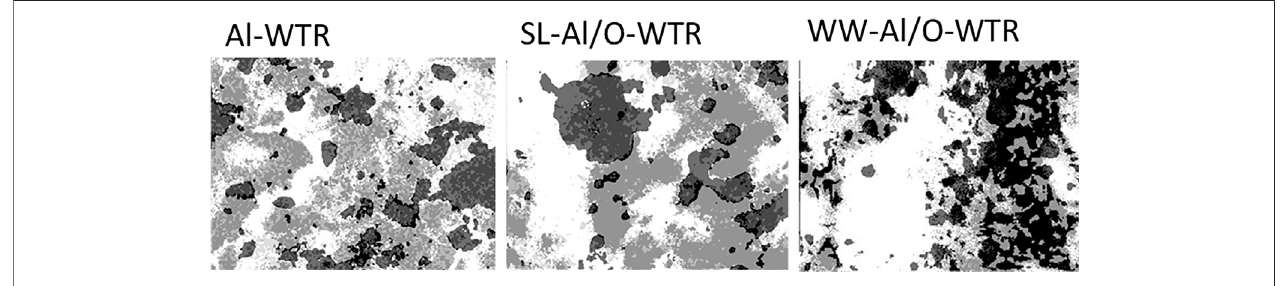
FIGURE 5 | The segmented images of Al-WTR, SL-Al/O-WTR and WW-Al/O-WTR.